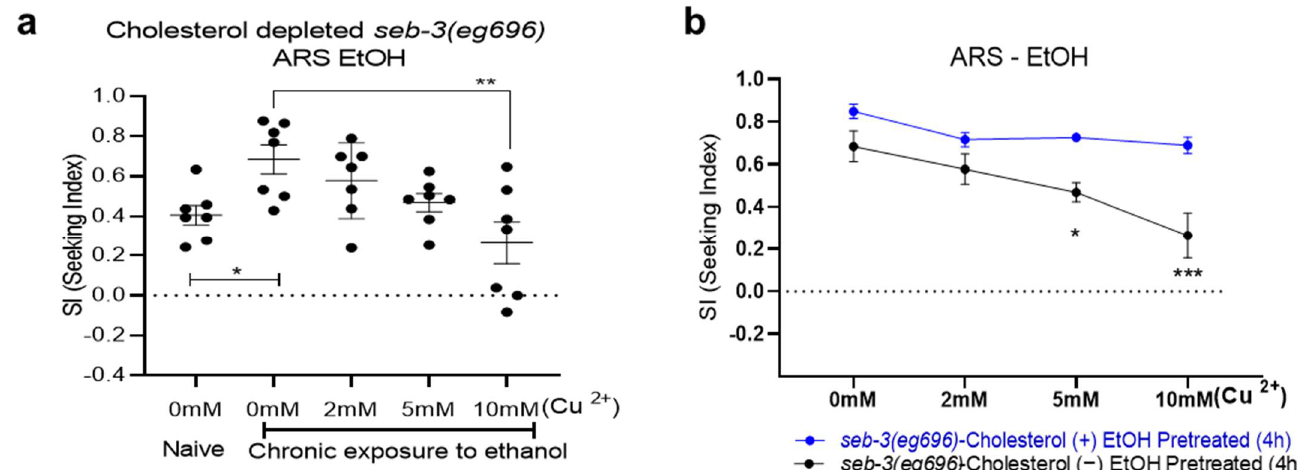
Figure 3. Cholesterol depletion suppressed the development of ARS in seb-3 gf animals that were susceptible to ethanol dependence (ARS: aversion-resistant seeking). ( a ) The cholesterol-depleted seb-3(eg696) animals developed ethanol preference after ethanol pretreatment for 4 h. One-way ANOVA, p = 0.0035, F (4, 30) = 4.948, post hoc multiple comparison test; Dunnett’s ( p < 0.05, *; p < 0.01, **). Each dot represents an assay that used a population of 100–150. ( b ) Data sets ( a ) from cholesterol-depleted animals were compared to the control group: cholesterol-fed seb-3(eg696) animals. The cholesterol-depleted seb-3(eg696) animals demonstrated development of ethanol preference as much as did the animals that were fed cholesterol, whereas significantly reduced SIs in the 5 mM and 10 mM barriers represented ARS. [Fcholesterol (1, 40) = 26.29, p < 0.0001; Fconc (3, 40) = 6.210, p = 0.0015; Fcholesterol × conc (3, 40) = 1.811, p = 0.1607]. N numbers were [five in each cholesterol-fed seb-3(eg696) concentration and seven in each cholesterol-depleted seb-3(eg696) concentration]. A two-way ANOVA comparison showed significant differences based on cholesterol feeding, barrier concentration, and the interaction of the two. The Bonferroni method was used for multiple comparison correction as a post hoc test, and found significant differences in ARS (at 5 mM and 10 mM barriers) between cholesterol feedings (fed vs depleted). p < 0.05, *; p < 0.001, ***.